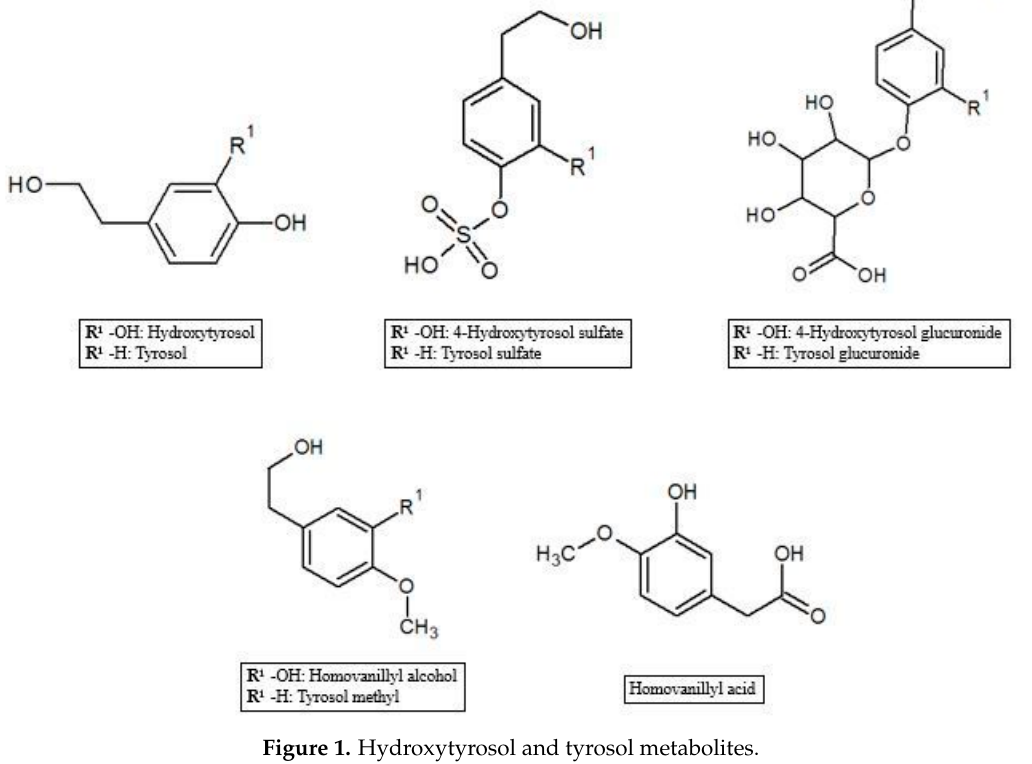
Figure 1. Hydroxytyrosol and tyrosol metabolites.